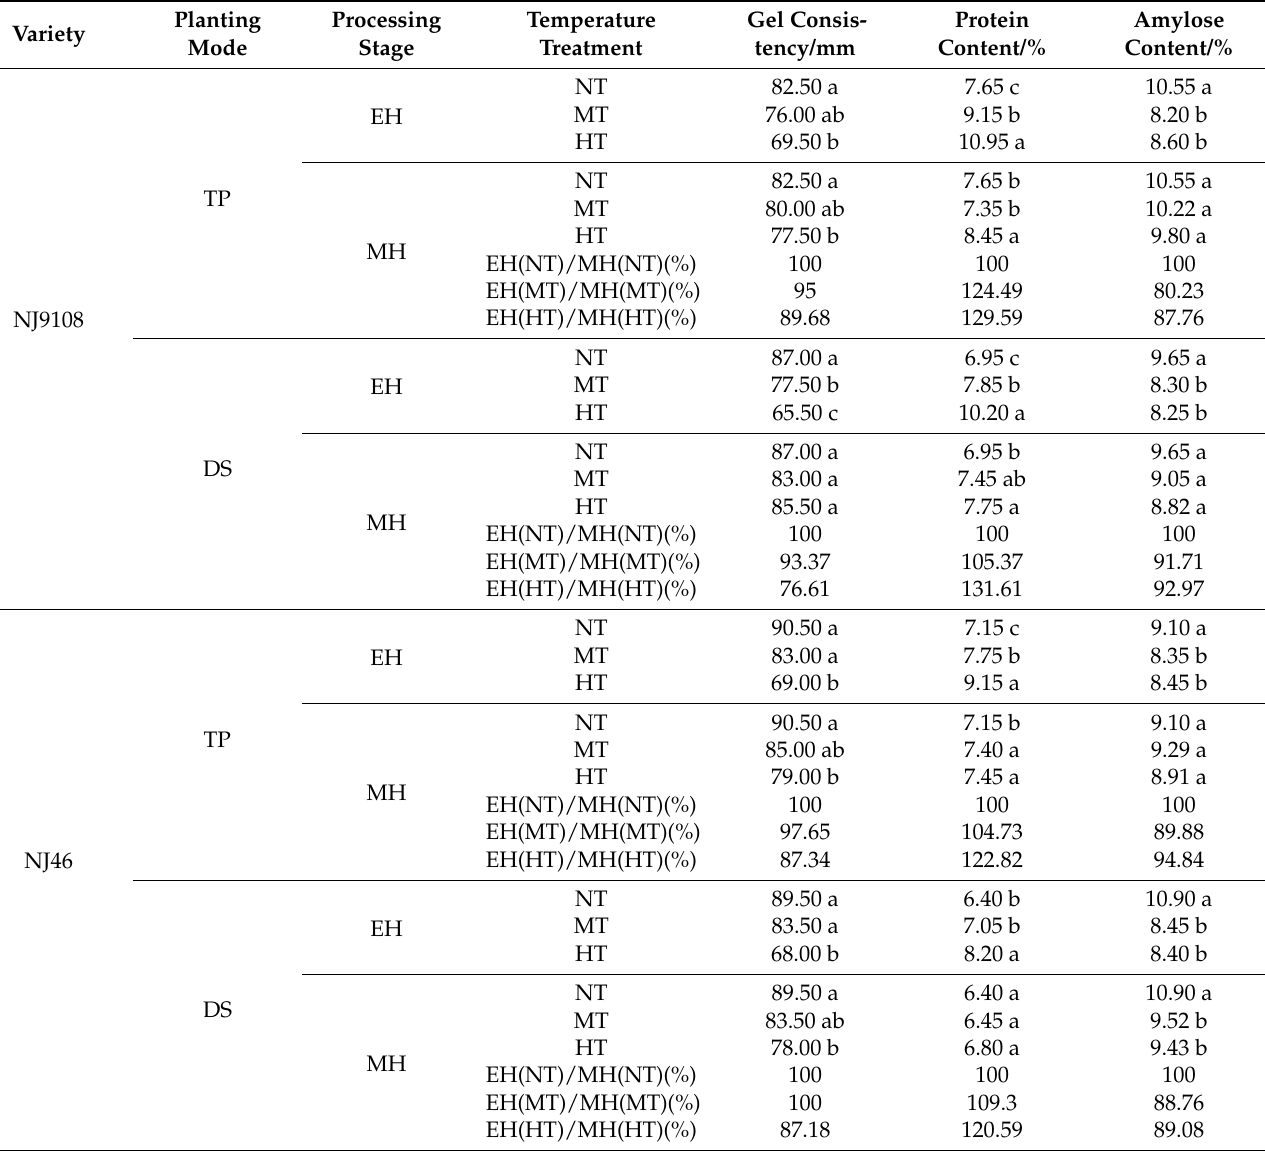
Table 5. Effects of high temperature on cooking and eating quality of japonica rice in early and middle heading stage under transplanting and direct